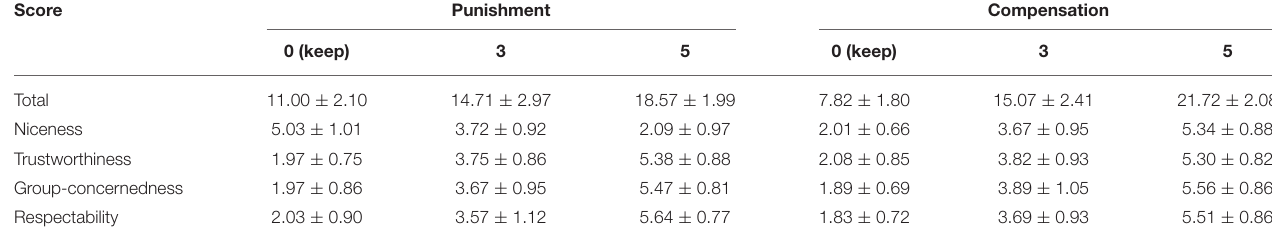
TABLE 1 | The reputational score when third parties were not free to choose ( M ± SD ).